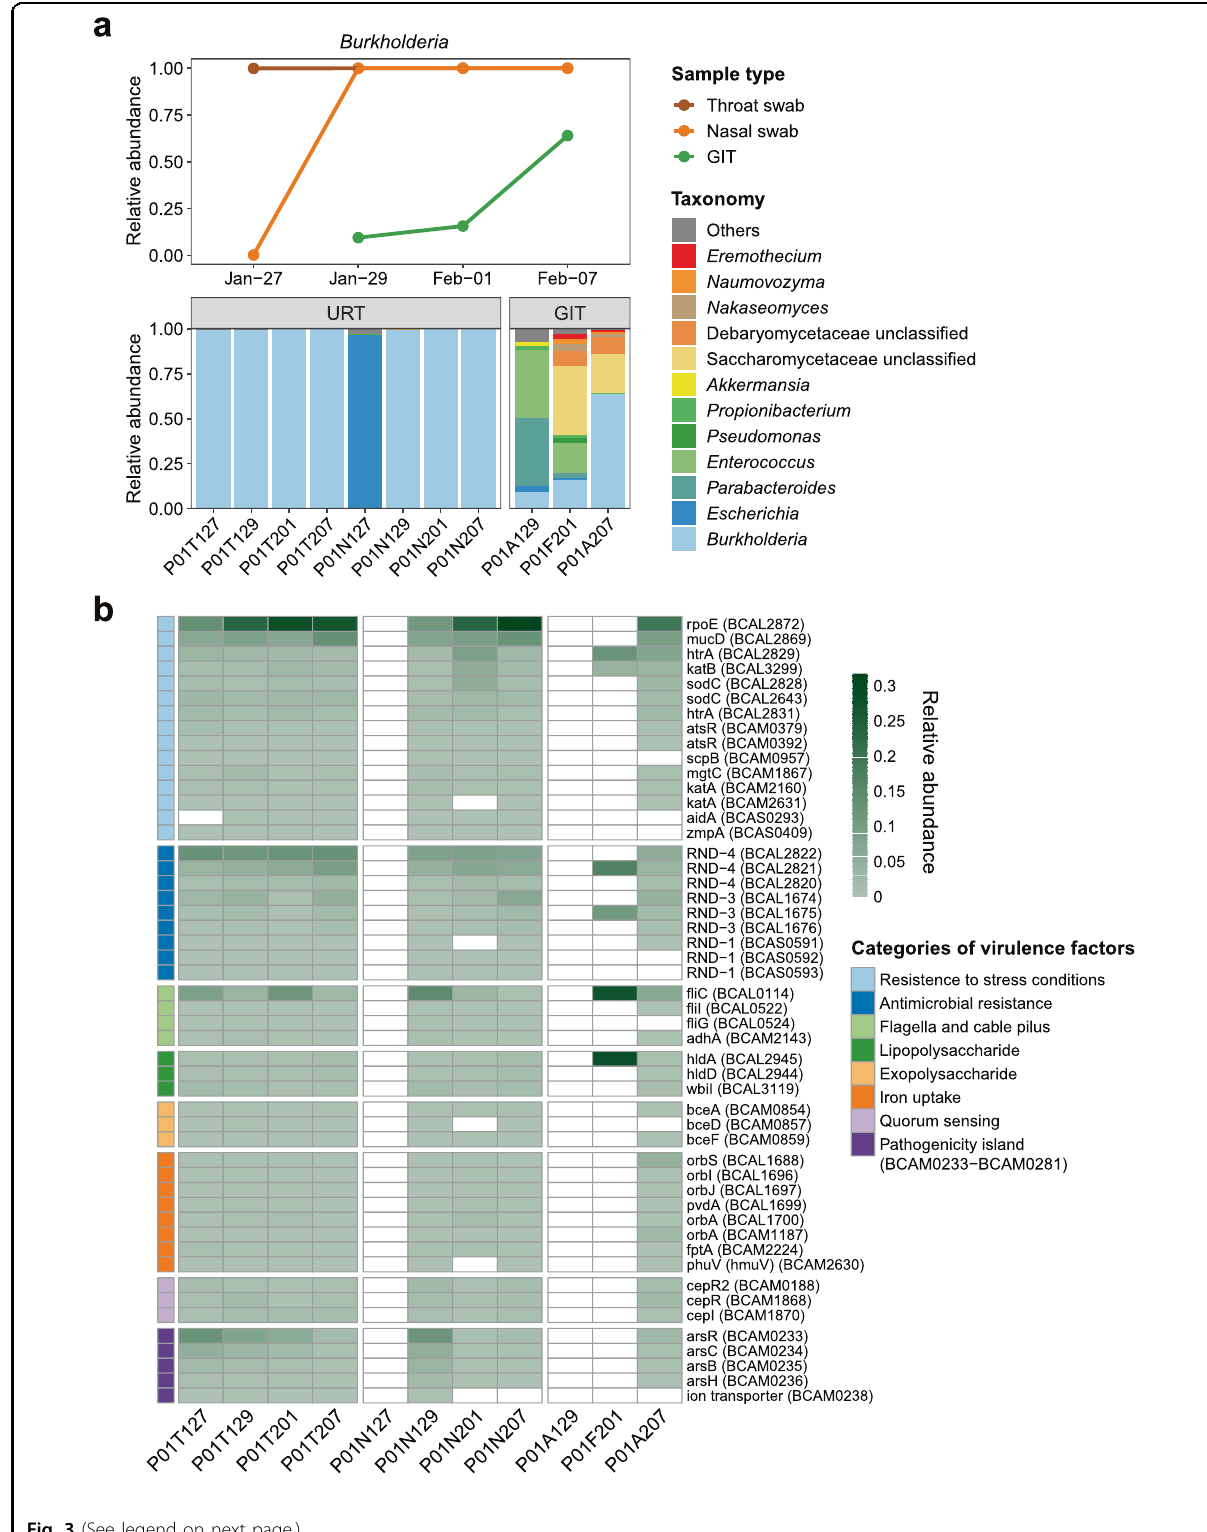
Fig. 3 (See legend on next